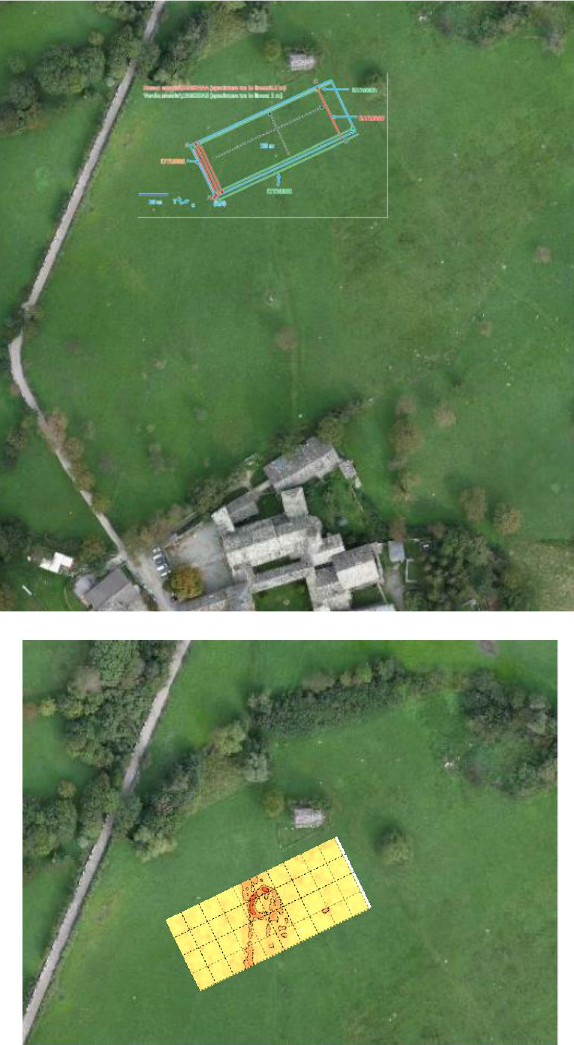
Figure 5. (Above) GPR profiles planning, topographically located onto the orthophoto. (Below) Superimposition of time- slice at 0.7 m of depth on orthophoto, with main anomalies derived from geophisical prospections